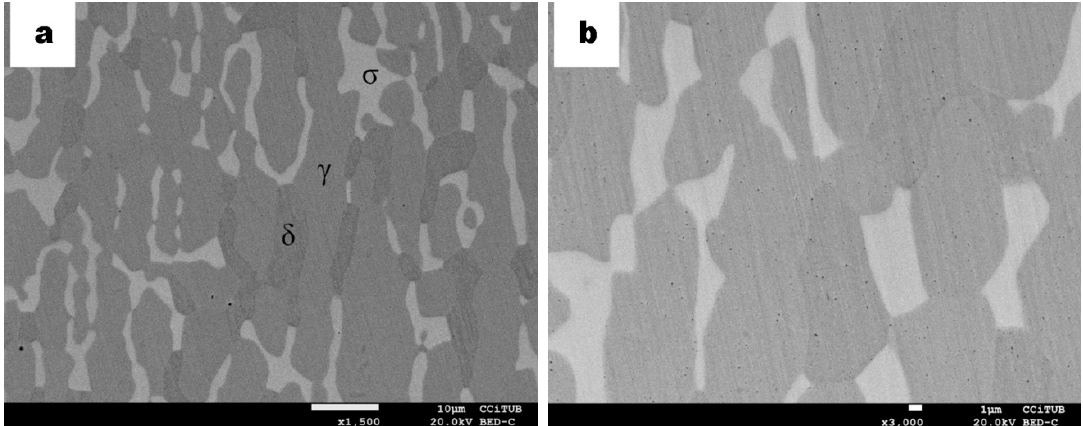
Figure 8. BSE micrographs of cross-section DSS specimens after isothermal aging for 10 h at 925 °C. ( a ) Microstructure of the sample indicating ferrite δ (greyer phase) as well as sigma σ (bright phase) and austenite γ (grey phase). ( b ) Higher magnification of central zone. Black spots presented heterogeneously in both micrographs are assigned to chromium carbides.